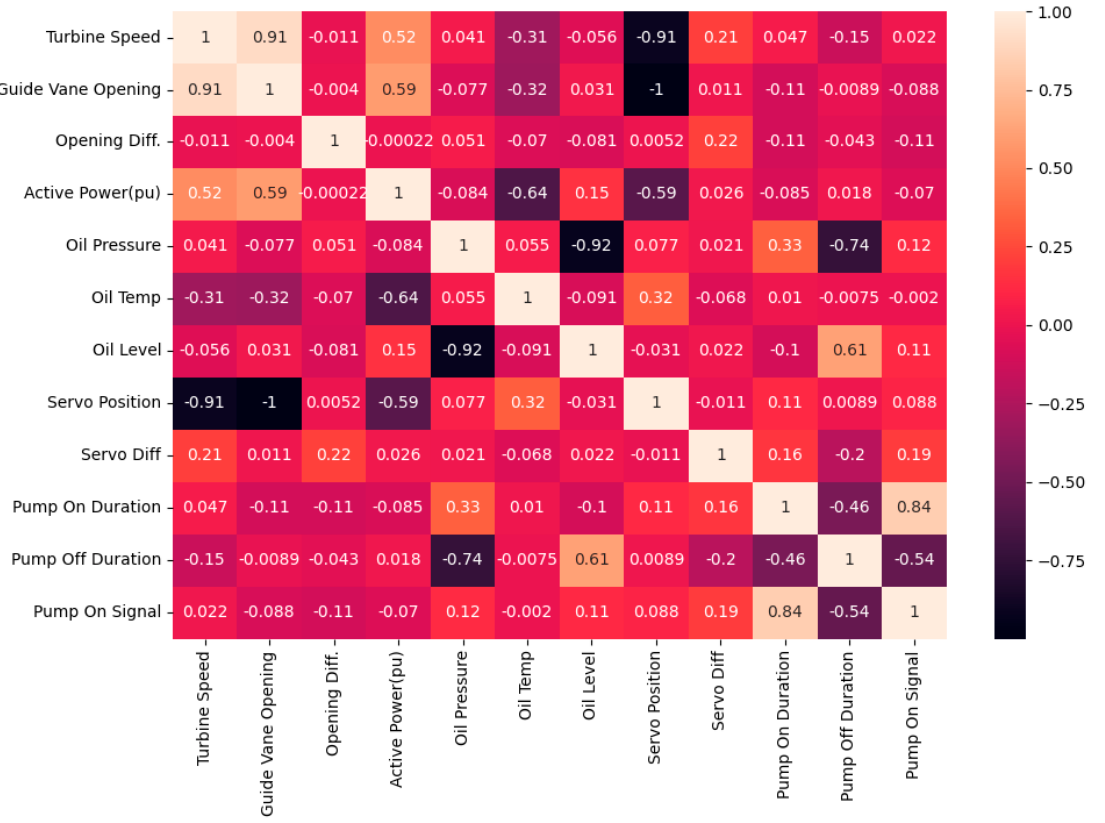
Figure 13. Heatmap showing the correlation between parameters in the training dataset. After eliminating data having no or negative effect on model performance, it was deemed appropriate to use the ones listed below with a resolution of 1 s. While selecting these data, the correlation values with the dependent variable, field experiences and model performance data obtained from various trials/tests were